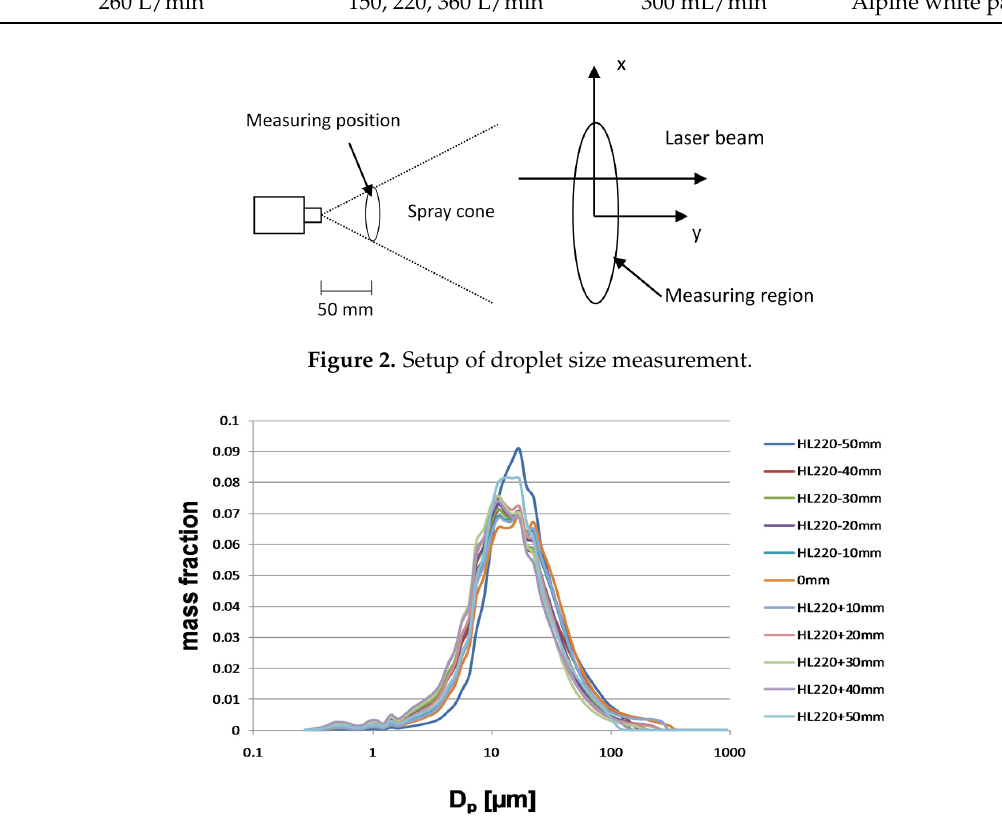
Figure 3. Individual droplet size distributions in the whole elliptical spray region for the shaping air flow rate of 220 L/min. 0 mm is the measuring position that is located at x = 0 in Figure 2, the spray cone center. ±50 mm are located at the edges of the elliptical spray region ( x = ± 50 mm).